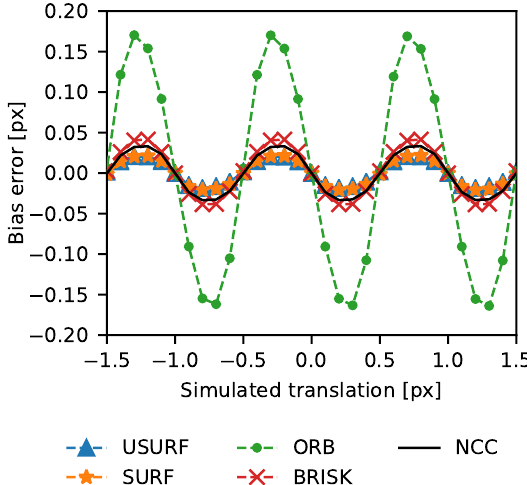
Figure 4. Accuracy of translation measurements made using the ORB, BRISK, USURF, and SURF feature tracking methods, using artificially translated speckle patterns to show the remaining pixel locking effect. The normalised cross-correlation with a 3-point Gaussian peak fitting results are shown for